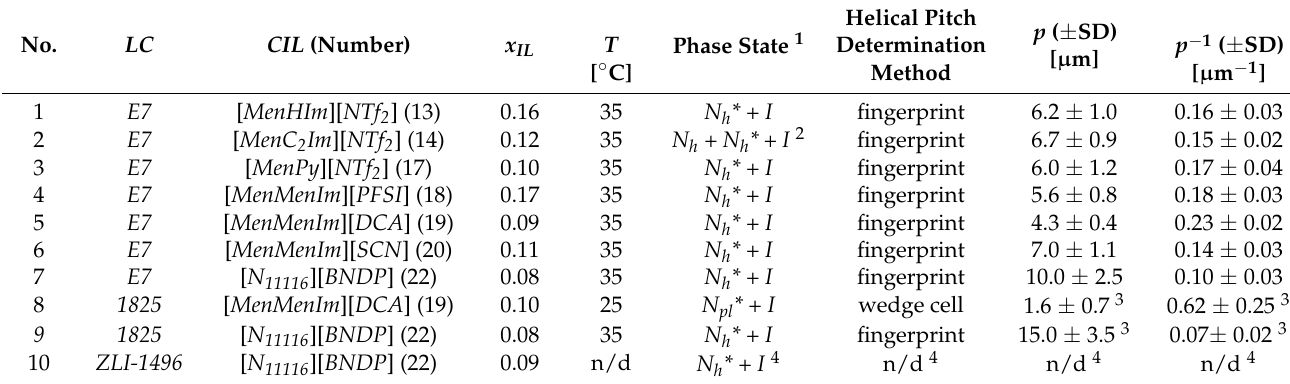
Table 1. The results of the helical pitch measurements of the LC with CIL mixtures exhibiting the twisted nematic phase. The results are related to the saturated solutions of the CILs in the LC